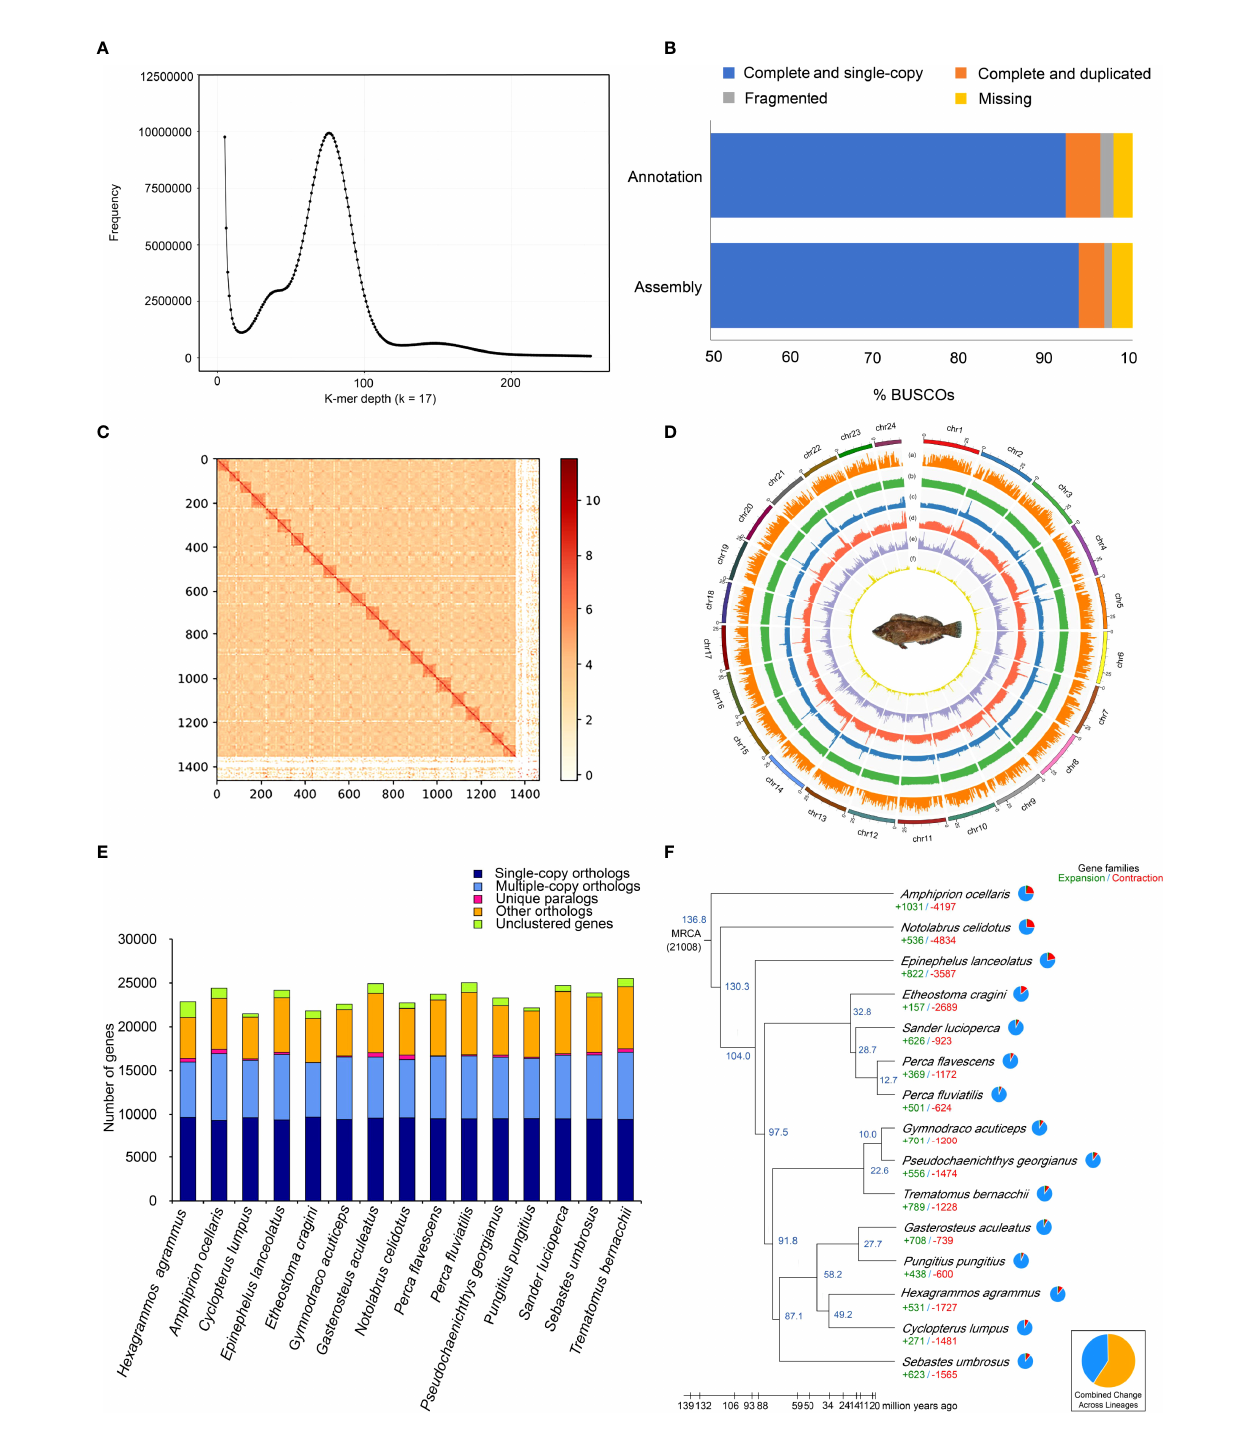
FIGURE 1 | Summary of the sequencing and comparative genomic results. (A) Genome size estimation with Illumina short reads; (B) 96.5% and 96.2% of the complete BUSCO were found in genome assembly and annotation, respectively; (C) Statistics of the Hi-C assembly of the H. agrammus genome; (D) Genome characteristics of H. agrammus . The results from the outer circle to the inner circle are as follows: (a) Gene density; (b) GC content; (c) Illumina sequencing data depth; (d) PacBio sequencing data depth; (e) DNA TE content; (f) LTR content; (E) Ortholog clustering results among 15 species; (F) Phylogenetic tree showing the divergence time of H. agrammus with 14 other fi sh